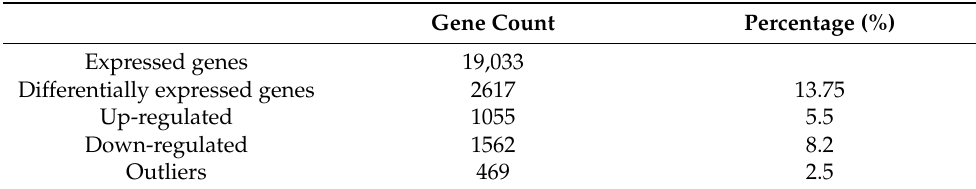
Table 3. Differentially expressed genes of R. kuepferi transcriptomes regarding the comparison of interest (cytotypes,